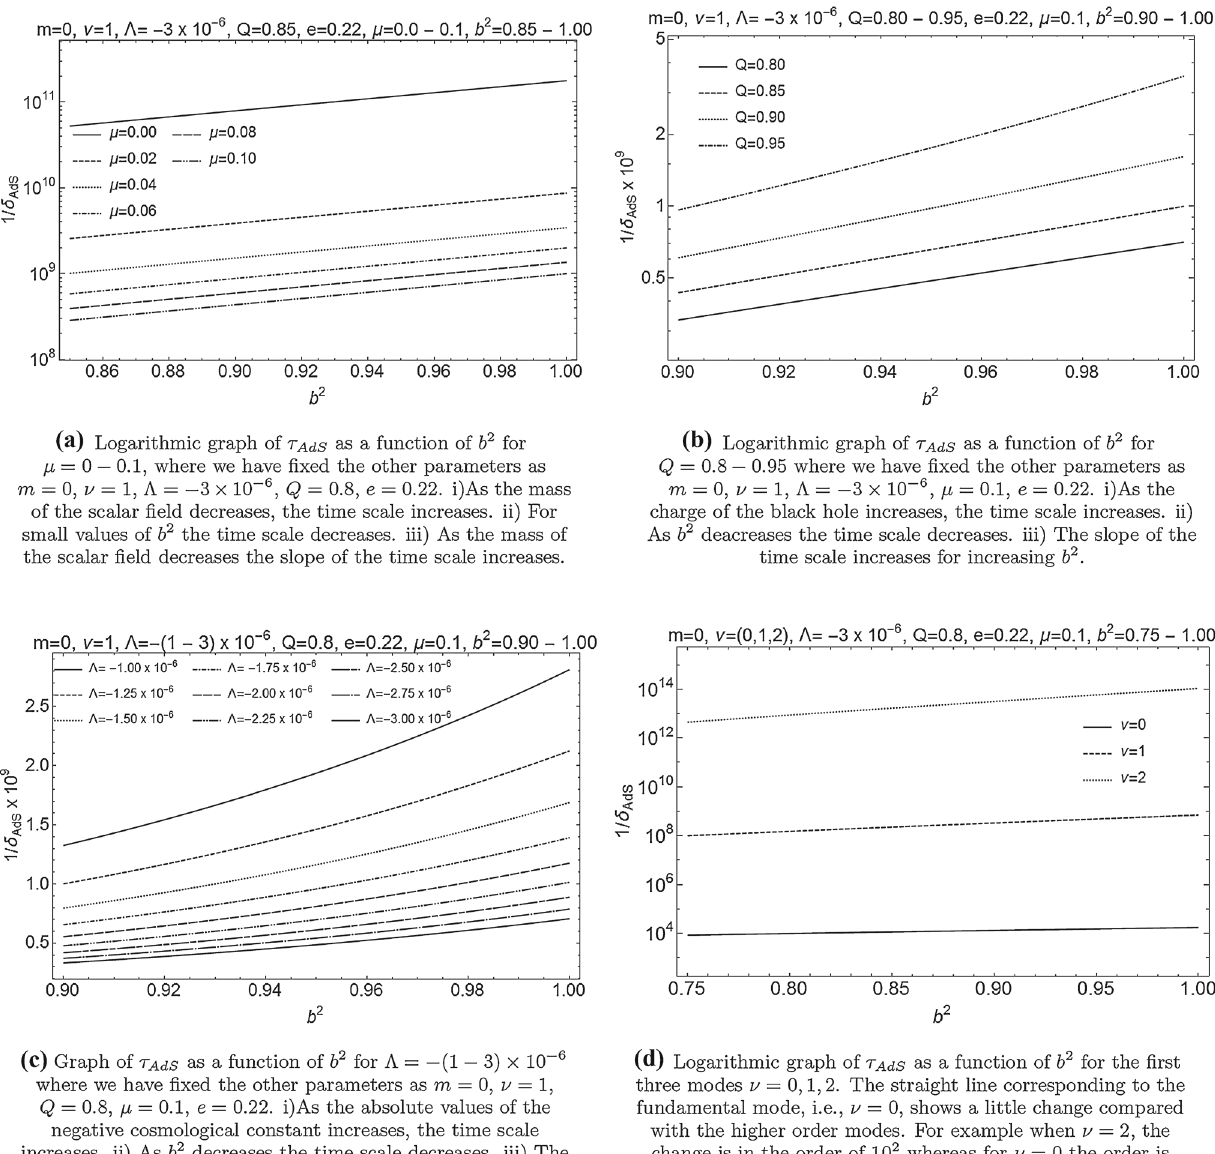
Fig. 2 Figure ( a – d ) corresponds to the different values of particle mass, black hole charge, cosmological constant and modes, respec- tively, shows the change of the time scale with respect to b 2 . All four